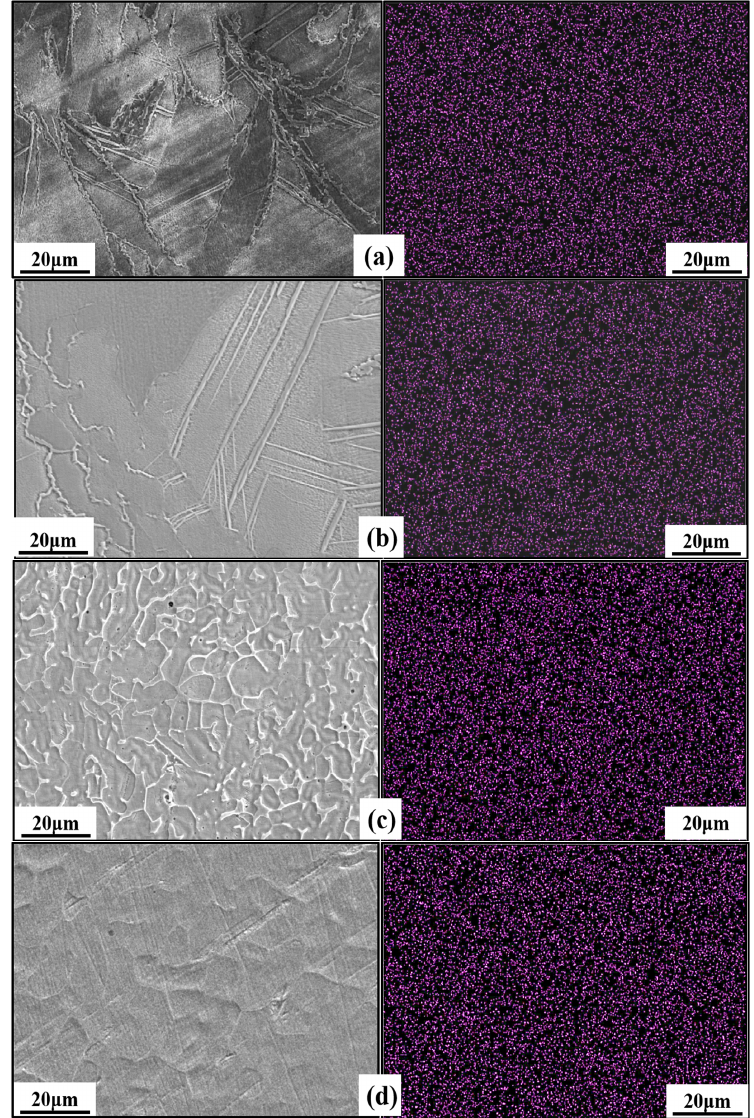
Figure 8. Micromorphology and nitrogen distribution in the samples formed using di ff erent SLM methods: ( a ) SLM overlay layers; ( b ) SLM scan layers; ( c ) X-Z cross-sections of the HPSLM speci- mens; ( d ) X-Y cross-sections of the HPSLM specimens.